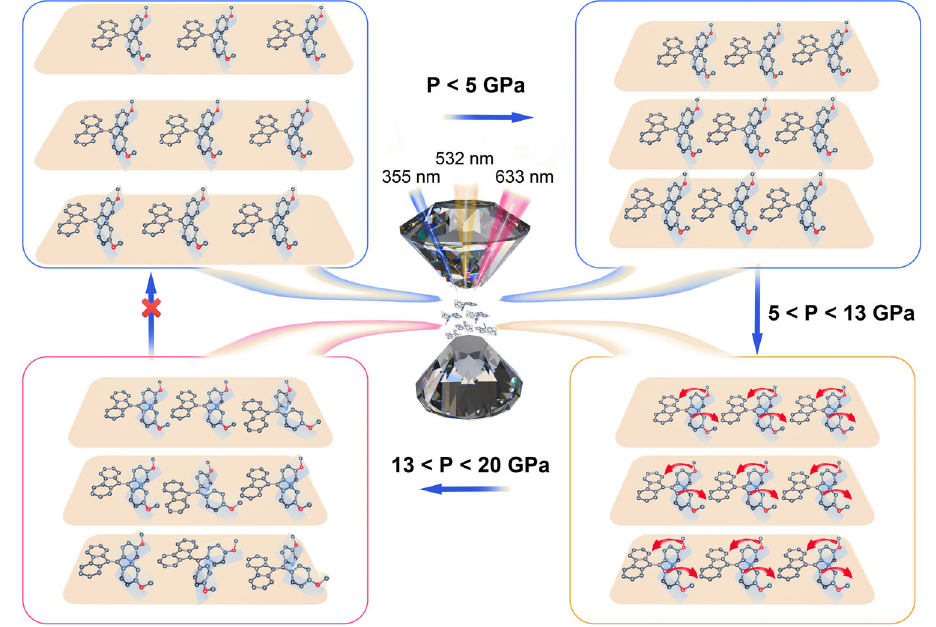
Fig. 4 | Schematic of FTPE crystal structural evolution under high pressure via multipleexcitationchannels. Theentirecompressionprocesscanbedividedinto three stages: (1) the pressure reduces the distance between the molecules, parti- cularlyalongthe b -axis,withoutobviousmolecularconformationchange,(2)owing